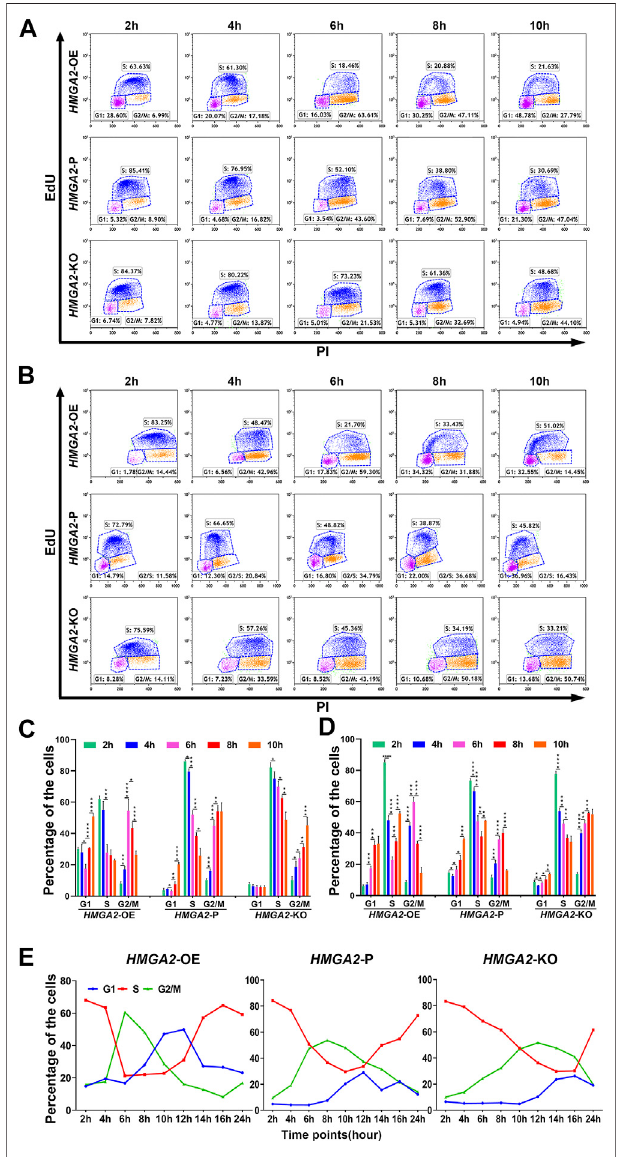
FIGURE 3 | HMGA2 shortens S – G2/M phase transition of the cell cycle in two GC cell lines. (A, B) Cell cycle analysis at indicated time points via fl ow cytometry. Results from the (A) MKN-45 cells and (B) MGC-803 cells. Horizontal lines: upper , HMGA2 -OEcells; middle , HMGA2 -Pcells; bottom , HMGA2 - KOcells.Verticallines:differenttimepointsaftersynchronizingthecellstotheG1/S boundary. The time points are 2, 4, 6, 8, and 10 h. EdU negative and PI negative indicatethecellsintheG0/G1phase;EdUpositive:cellsintheSphase;PIpositive: cells in the G2/M phase of the cell cycle. (C,D) Statistical histogram of the cellular percentageineachcellcyclephaseatindicatedtimepoints. (C) MKN-45cellsand (D) MGC-803 cells. X -axis: different cell cycle phases of the different HMGA2 - edited cells. Y -axis: percentageofthe cells. Left fl ock: HMGA2 -OEcells; middle fl ock: HMGA2 -Pcells; right fl ock: HMGA2 -KOcells.* p < 0.05,** p < 0.01,*** p < 0.001, **** p < 0.0001, Student ’ s t-test. Error bars represent SD. (E) Dynamic percentage of the cells in each cell cycle phase recorded at continuous time. The cellcycleofMKN-45cellswasdetectedforasequenceof24 h via fl owcytometry aftersynchronizedtotheG1/Sboundary,andthedetectionwasconductedevery 2 h. Left: HMGA2 -OE MKN-45 cells; middle: HMGA2 -P MKN-45 cells; right: HMGA2 -KOMKN-45cells.Thered,blue,andgreenlinesrepresenttheproportion of cells in S, G1, and G2/M phases, respectively.